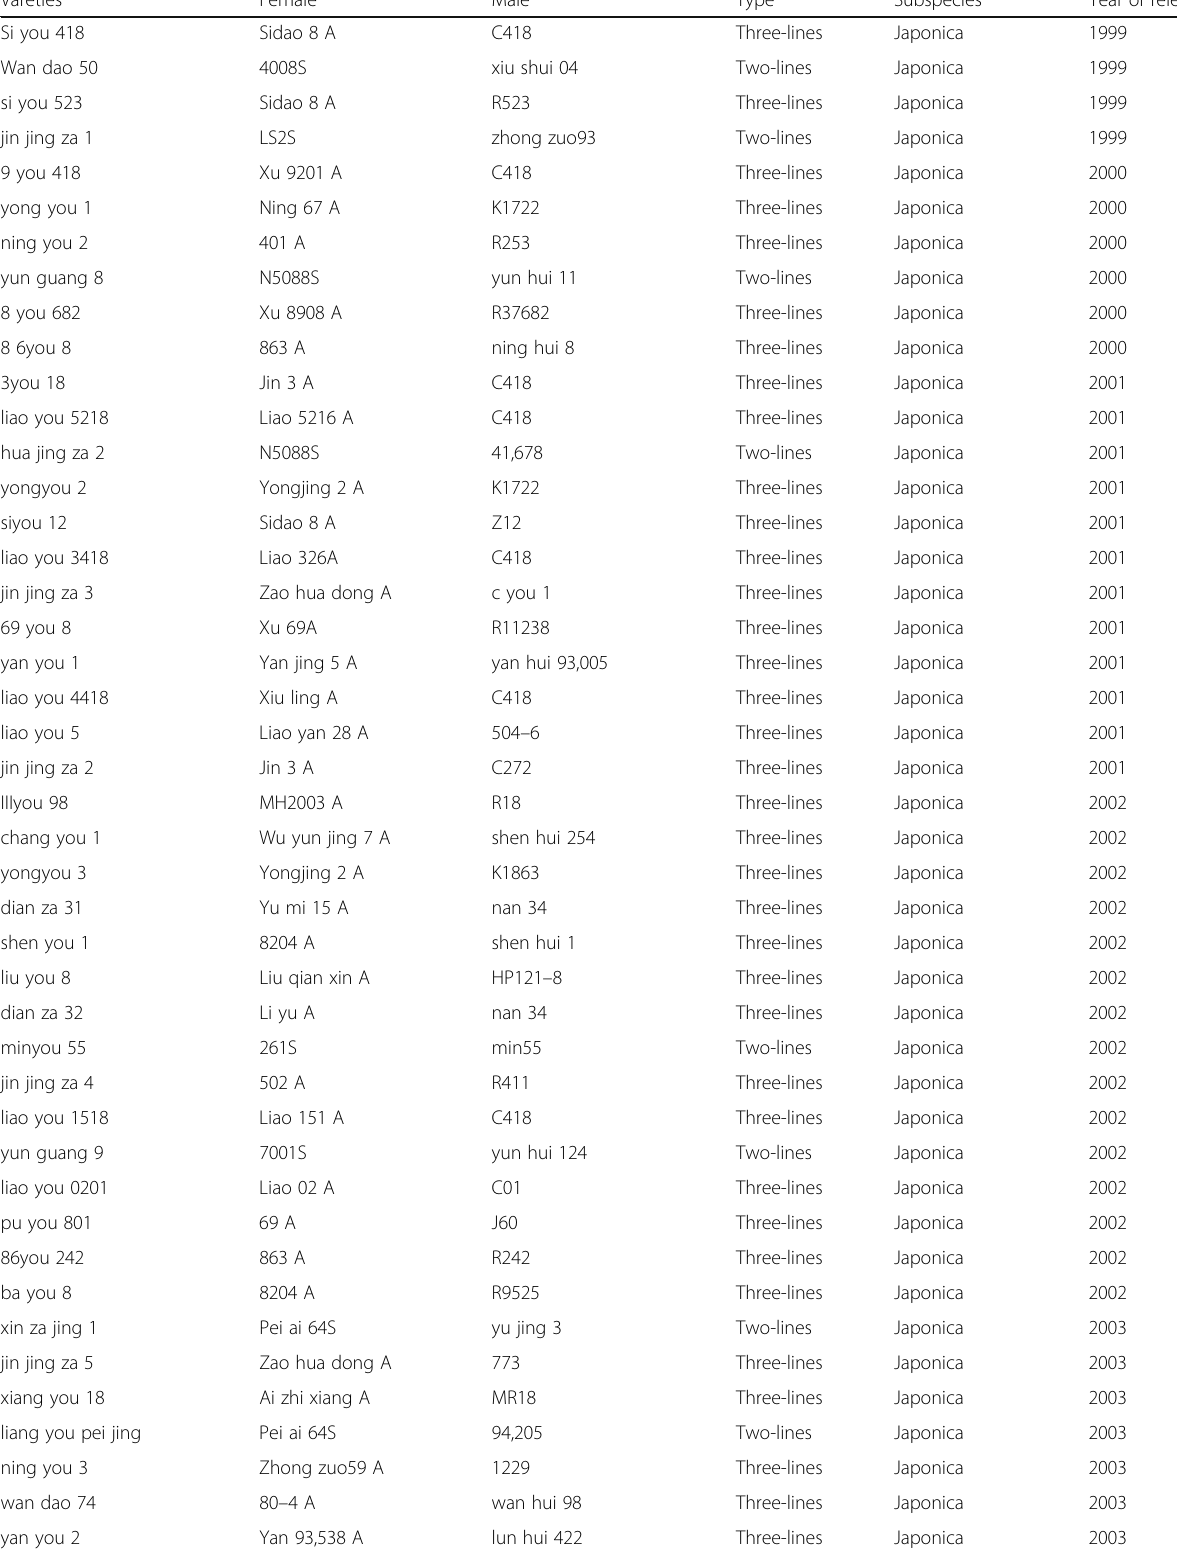
Table 1 List of hybrid japonica rice varieties bred in China (Continued)